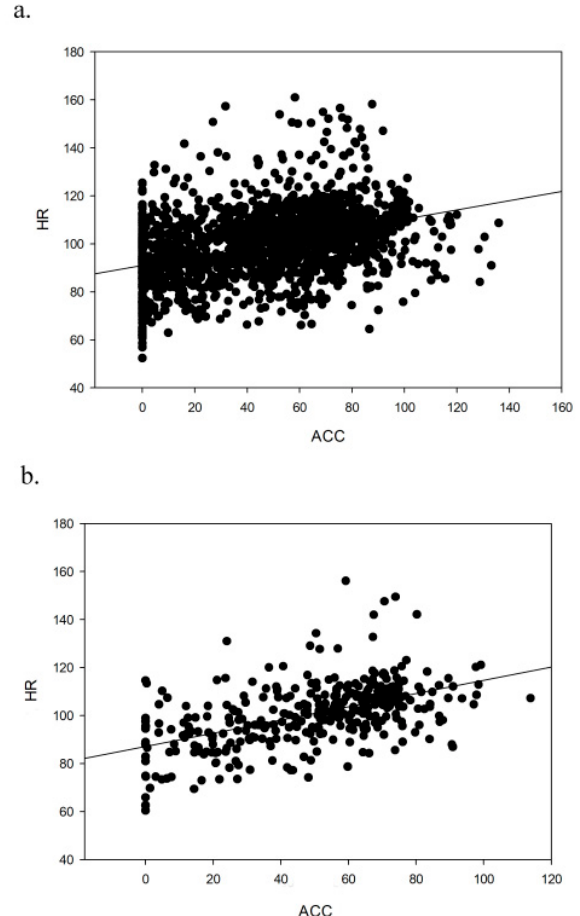
Figure 2. Linear regression of heart rate (beats per minute) and accelerometry (one-minute mean for the vector magnitude of the three axes) in the moderate-intensity aerobic session; ( a ) minute-by-minute, ( b ) 5-minute intervals.